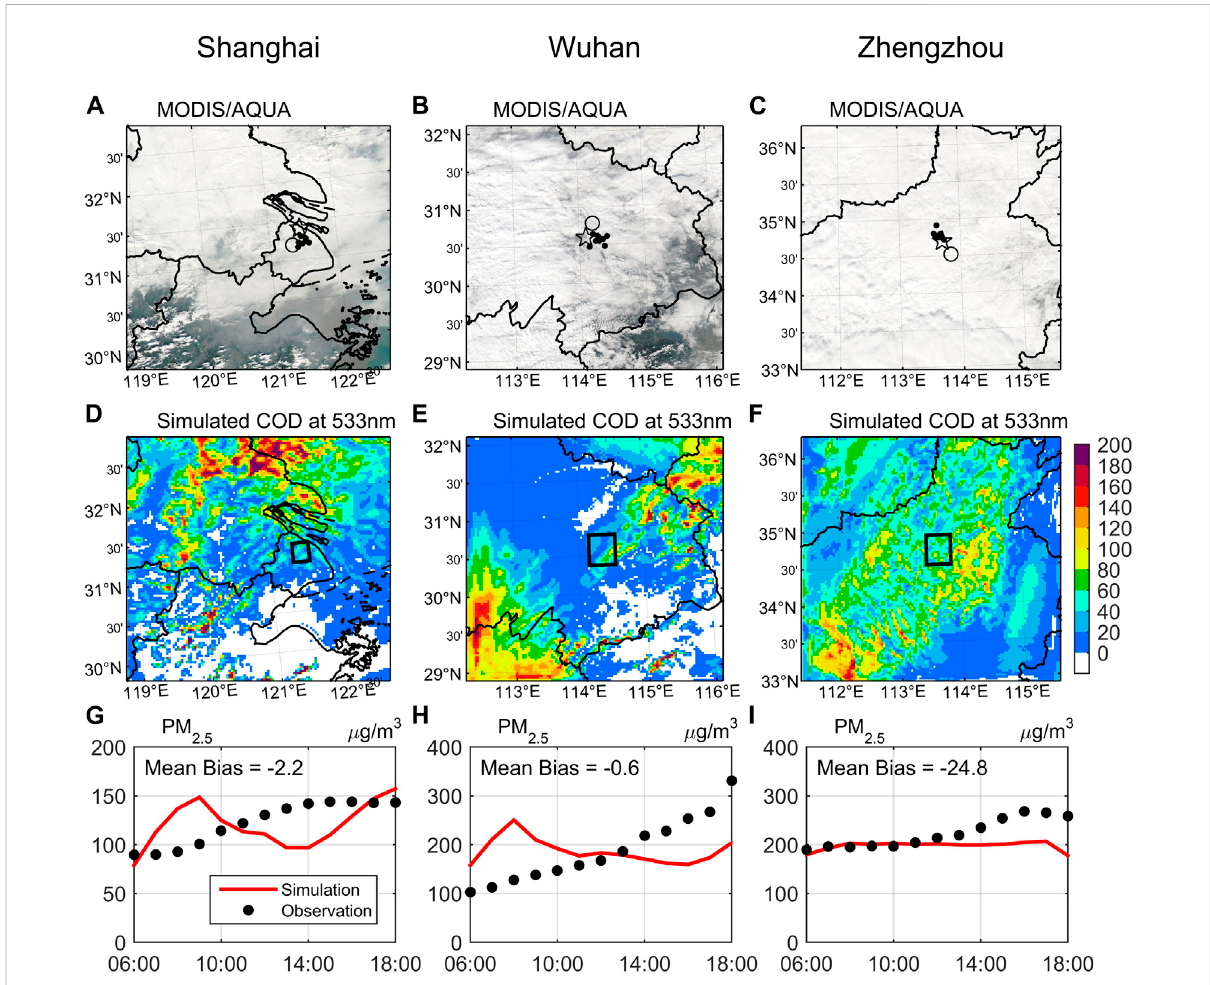
FIGURE 3 Evaluation of model performance. Left, middle and right column represents the cases of Shanghai (2016.11.19), Wuhan (2016.01.04) and Zhengzhou(2016.02.12), respectively. (A – C) Spatialdistributionofcorrectedre fl ectance (truecolor)ofMODIS/AQUAprojectedontothesimulation domain. Black dots, circles as well as pentagrams mark the locations of the in-situ measurements for PM 2.5 concentrations and meteorological factors, as well as radiosondes observations, respectively. (D – F) Spatial distribution of simulated cloud optical depth (COD) at 14:00LT. (G – I) Time series of simulated and observed PM 2.5 concentrations at ground